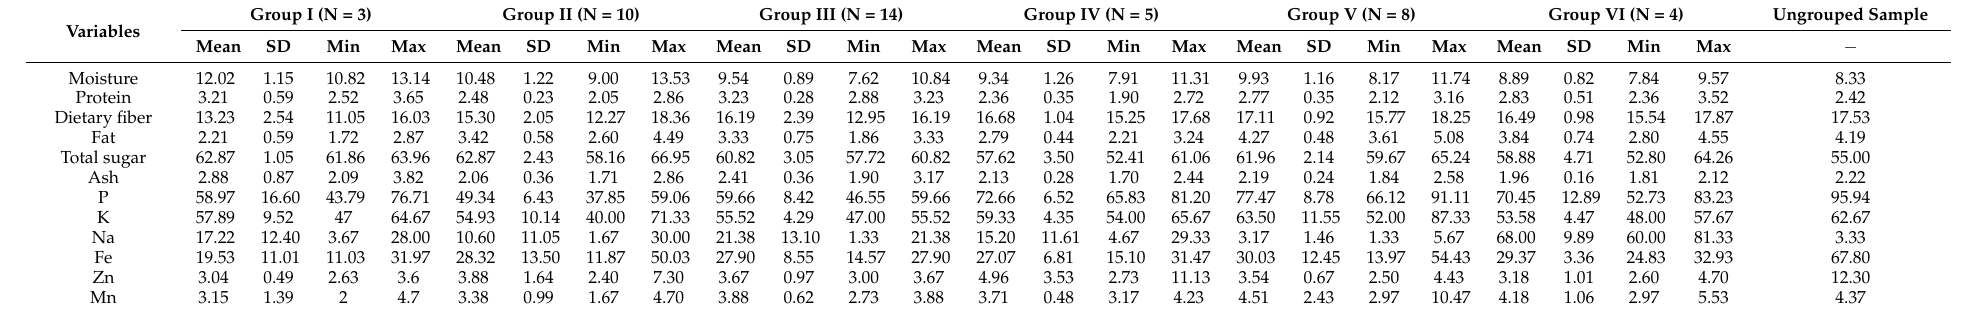
Table 4. Summary of the variation in nutritive value and mineral composition and the classification of harvested samples across groups generated by using Cluster analysis.